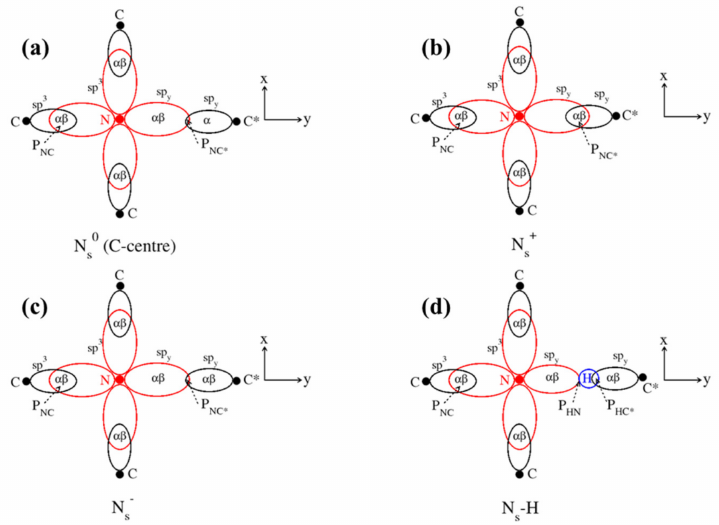
Figure 1. Two-dimensional stereographic projections of all four systems: ( a ) N 0 s , ( b ) N + s , ( c ) N − s , ( d ) N s -H. P NC/NH indicates bond